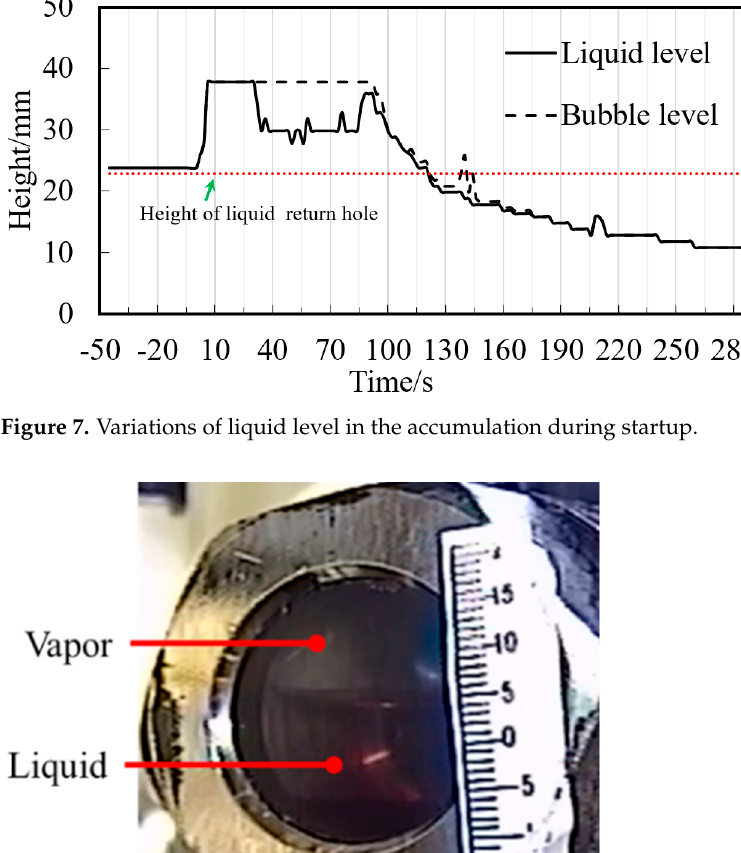
10 of 19 Figure 6. Test rotary compressor. Refrigerant R290 and mineral oil were used in the air-conditioning system. The sys- tem starts at a rated frequency of 60 Hz under the heating condition with the ambient temperature of − 7 ℃ . Before the system startup, it was placed in Psychometric Rooms for a long time to ensure that the temperature of all components and refrigerant distribution in the system were stable. The red colorant was added to the oil for easy observation. The stable experimental results were obtained after three repetitions of the same ex- periment. Figure 7 shows the variations of liquid level in the accumulation during startup of the compressor. Figure 8 shows the photos of the sight glass on the accumulator shell.